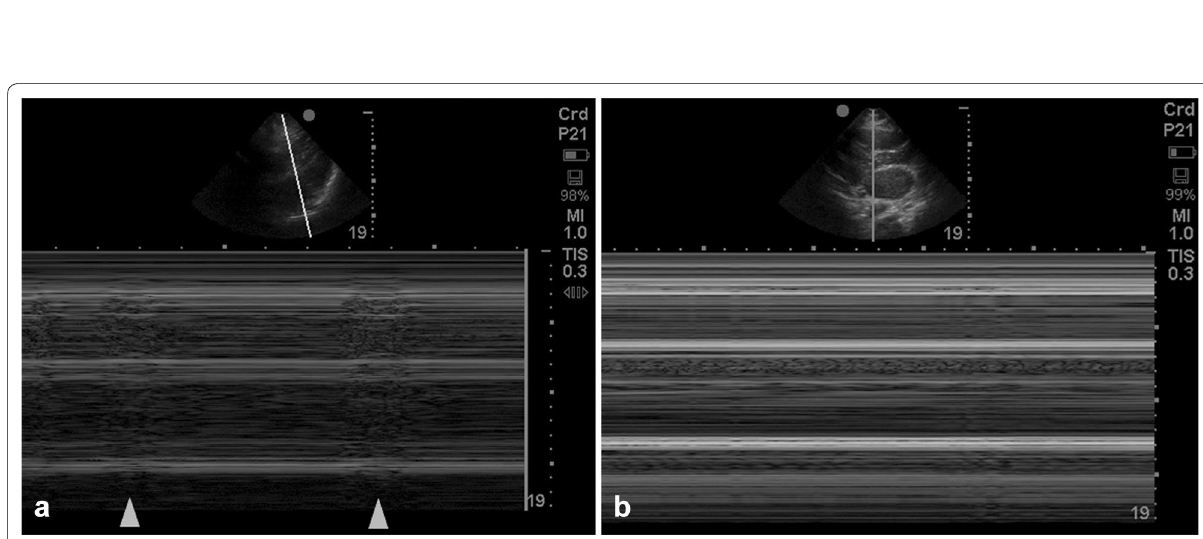
Fig. 3 M‑mode of the heart in asystole. a The horizontal lines represent absence of any movement across the M‑mode line. Areas which are grainy (arrows) indicate myocardial contraction. b Completely flat lines indicating no cardiac movement (true cardiac standstill)